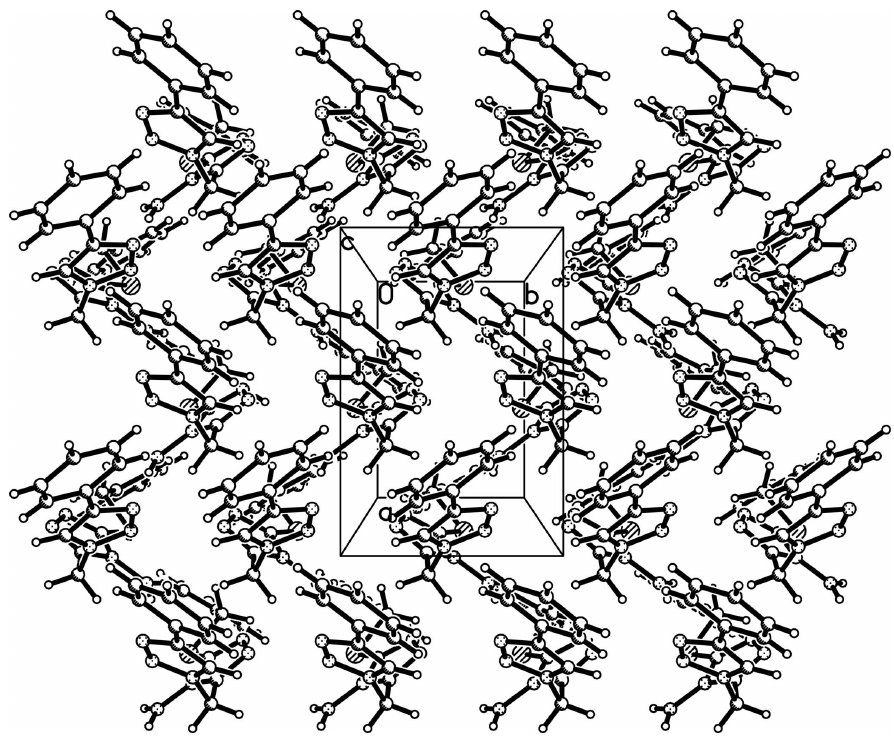
Figure 2 A packing diagram of (I), viewed down the c